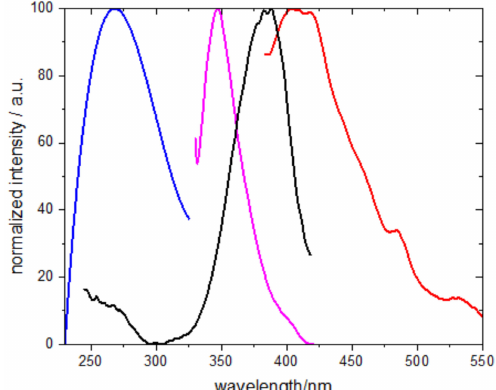
Figure 9. Excitation ( λ em = 350 nm, blue line) and emission ( λ ex = 265 nm, magenta line) spectra of Bpy-SH@AuNS in water solution. Excitation ( λ em = 410 nm, black line) and emission ( λ ex = 380 nm, red line) spectra of Bpy-SH@AuNT water